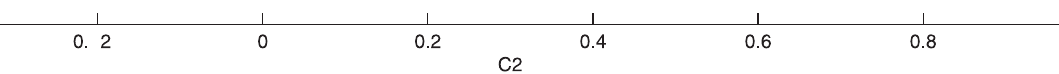
Figure 5. The recombination rate data forms two clusters in the plane of the second and third principal components. These coefficients are labeled C2 and C3, respectively. The recombination rate measured for each insert is written next to each point.